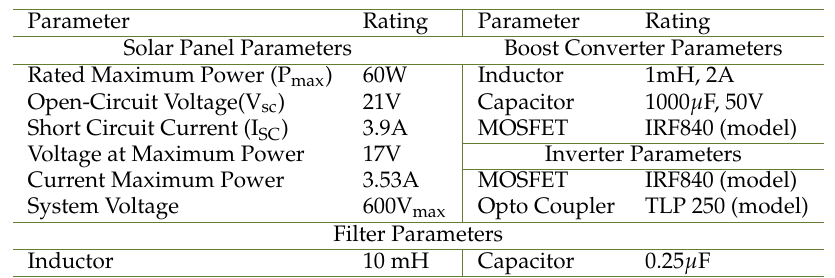
Table 1. Specification of experimental setup